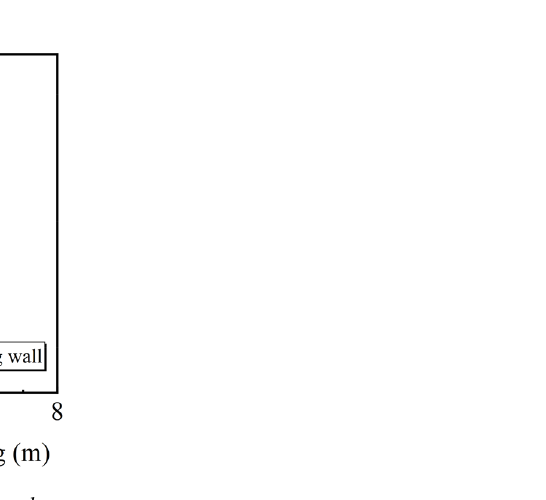
Figure 18. Local buckling location under different